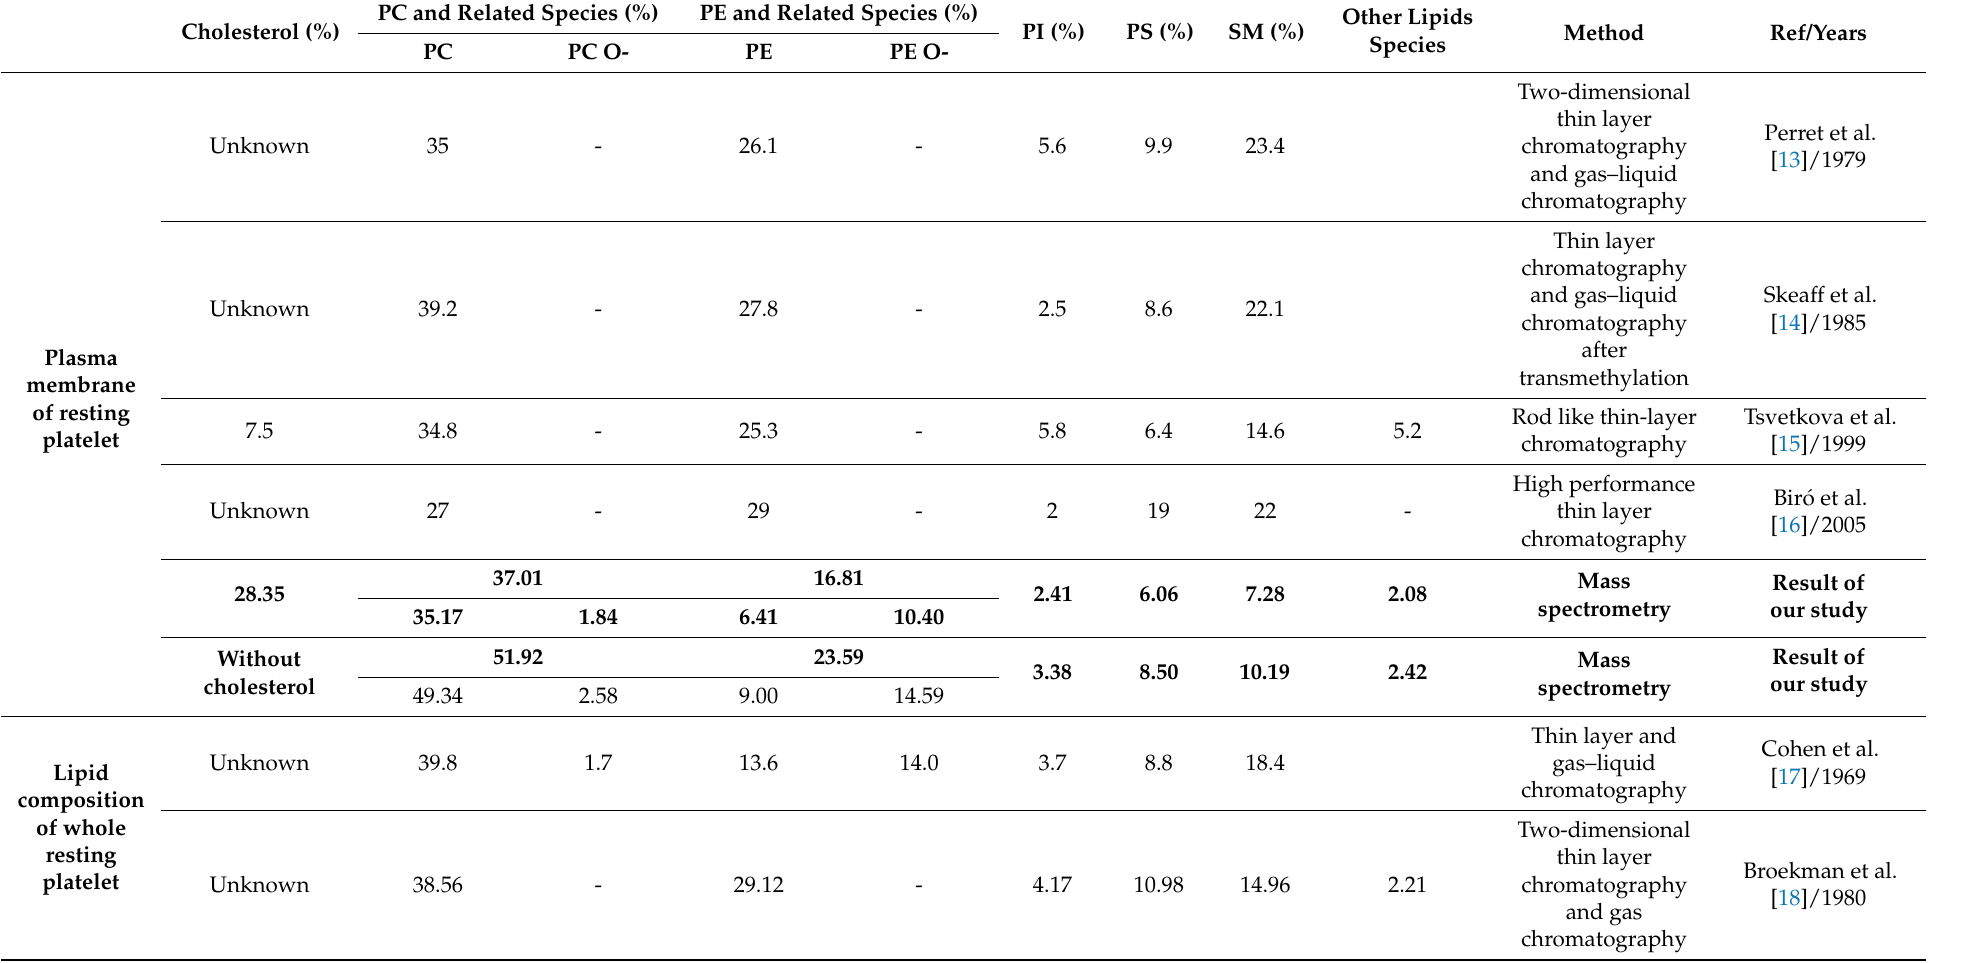
Table 1. Results of our lipid composition of plasma membrane of resting platelet or whole resting platelets compared to the previous lipid profile of the platelet described. Cholesterol